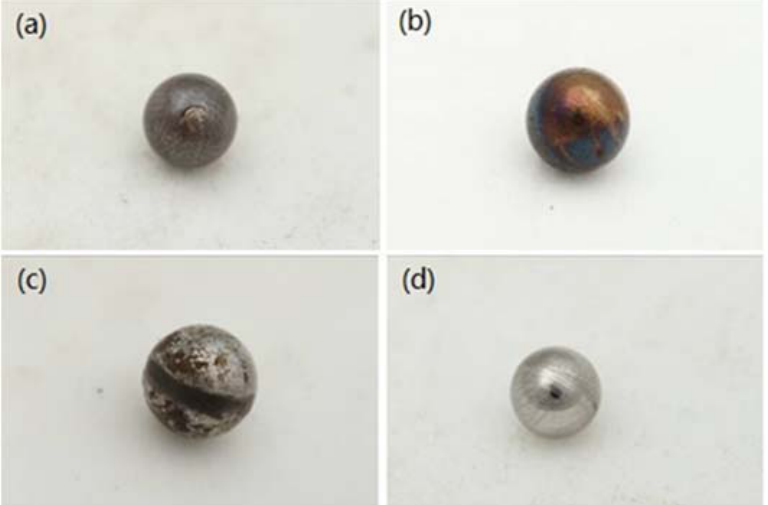
Figure 14. Comparison of burns during bearing service. ( a – d ) Different forms of steel ball burns.